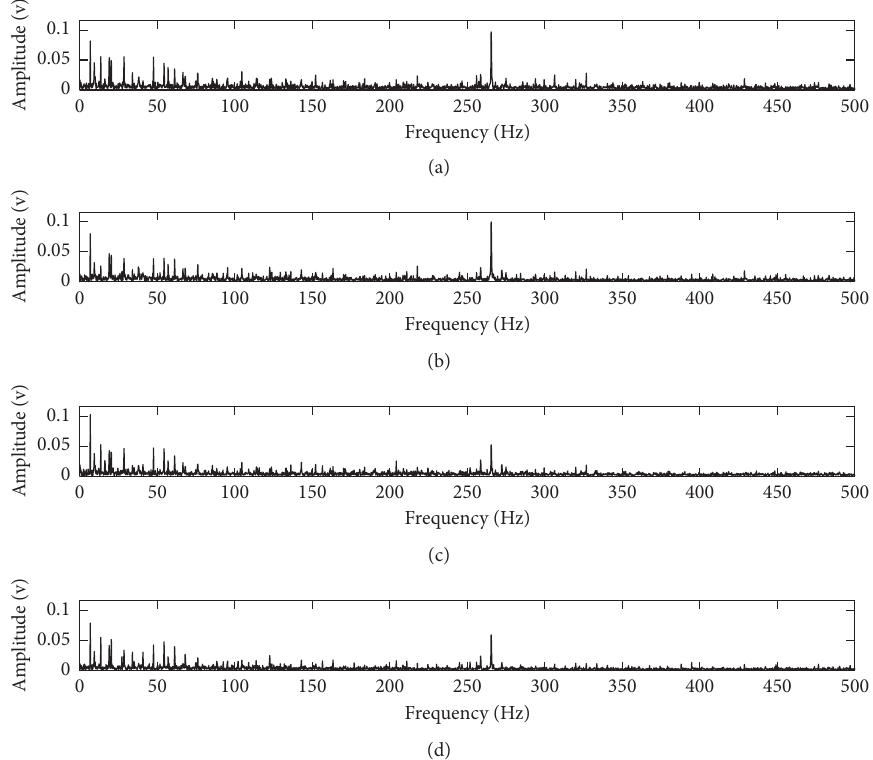
Figure 17: The envelope demodulation spectral analysis results of the signals as shown in Figure 16.